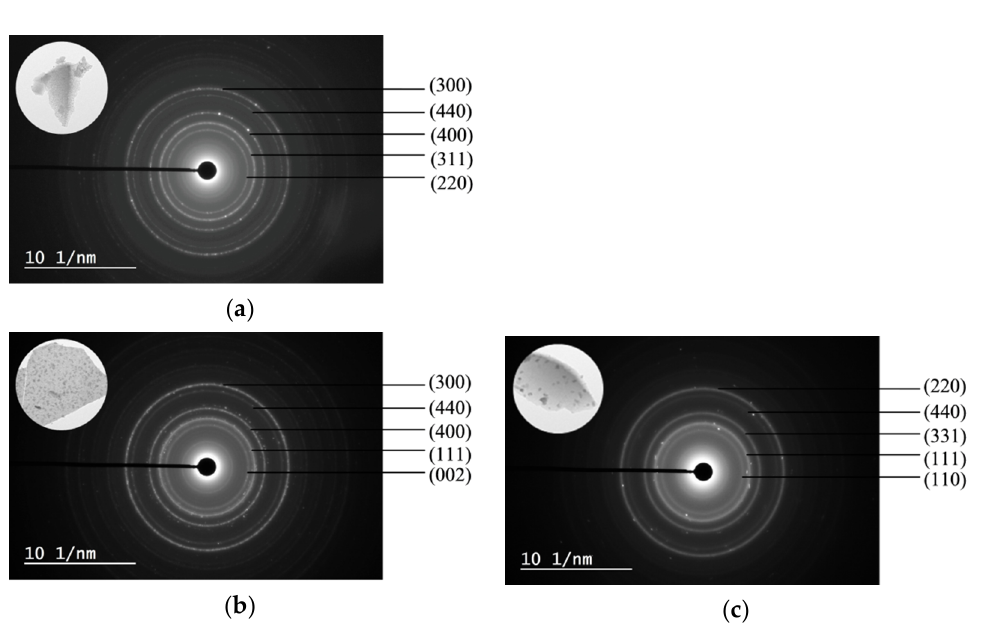
( b ) ( c ) Figure 8. XP spectra of the ( a ) 5Ni5CoAl, ( b ) 5Ni5CuAl and ( c ) 5Co5CuAl catalyst samples. 795